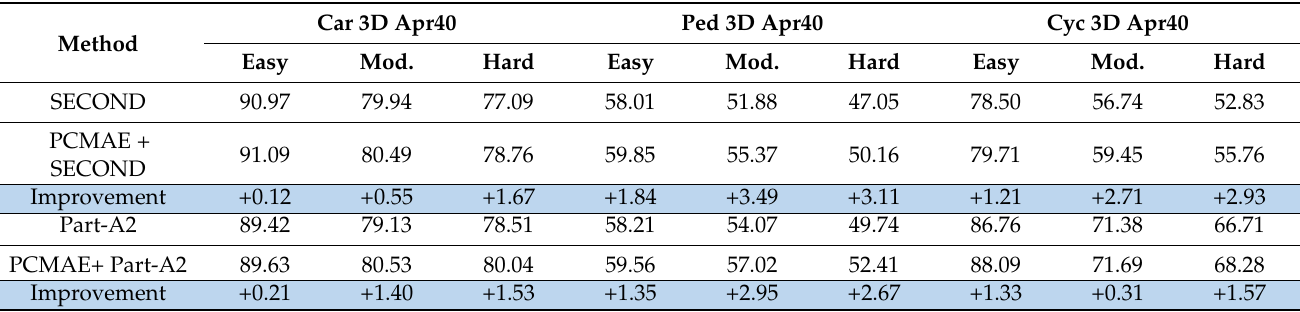
Table 1. Comparisons on the KITTI validation set, evaluated by the 3D Average Precision (AP) under 40 recall thresholds (R40). The rotated IoU (Intersection-over-Union) threshold is 0.7 for the car and 0.5 for the pedestrian/cyclist. The two comparison experiments are shown separately as test results (The difference between each comparative experiment is whether the PCMAE pre-training parameters are used for initialization, and the model structure and hyperparameters are the same), the blue part shows the gain of PCMAE to the two